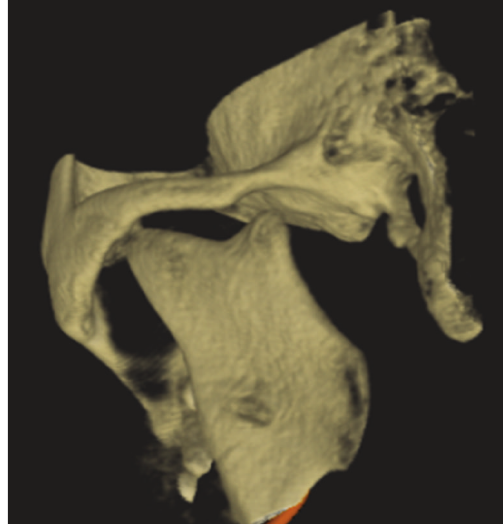
Figure 10: 3D CBCT left oblique lateral—shows hypoplasia of glenoid fossa and condyle.